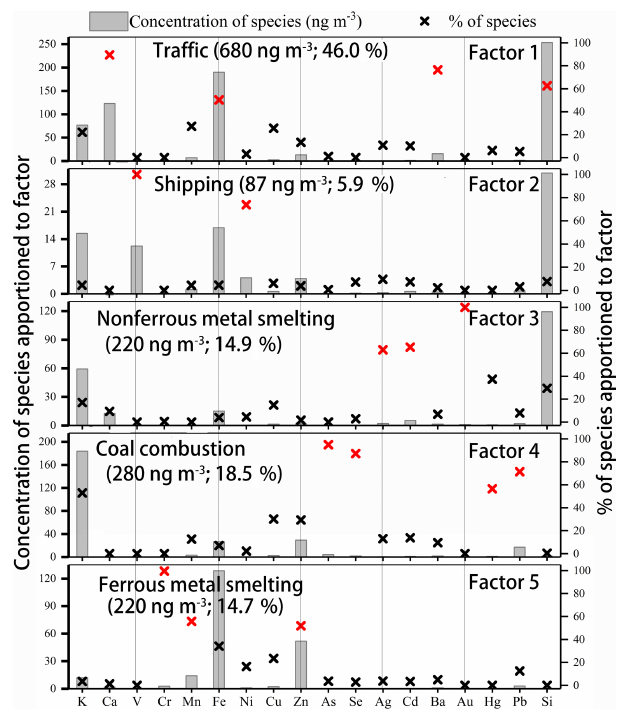
Figure 3. PMF-resolved source profiles (concentration and % of species apportioned to the factor) and average contributions (in the parentheses) of individual sources to the measured total PM 2 . 5 ele- ments in Shanghai. The notable species for each factor and source are marked in red.